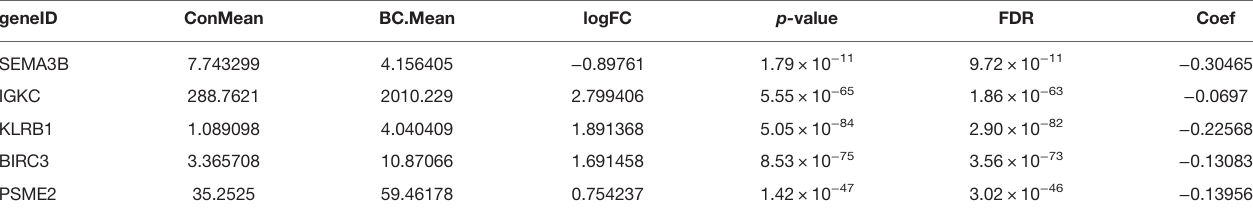
TABLE 2 | Mean expression and calculated difference value of fi ve genes.